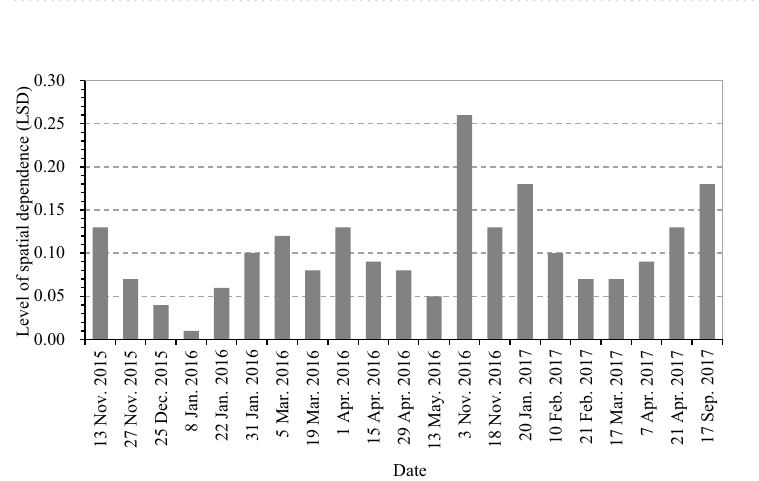
Figure 3. Spatial correlation data from P. xylostella populations produced by the semi-variance function model. We, Mo, and St represent weak, moderate, and strong spatial dependence,